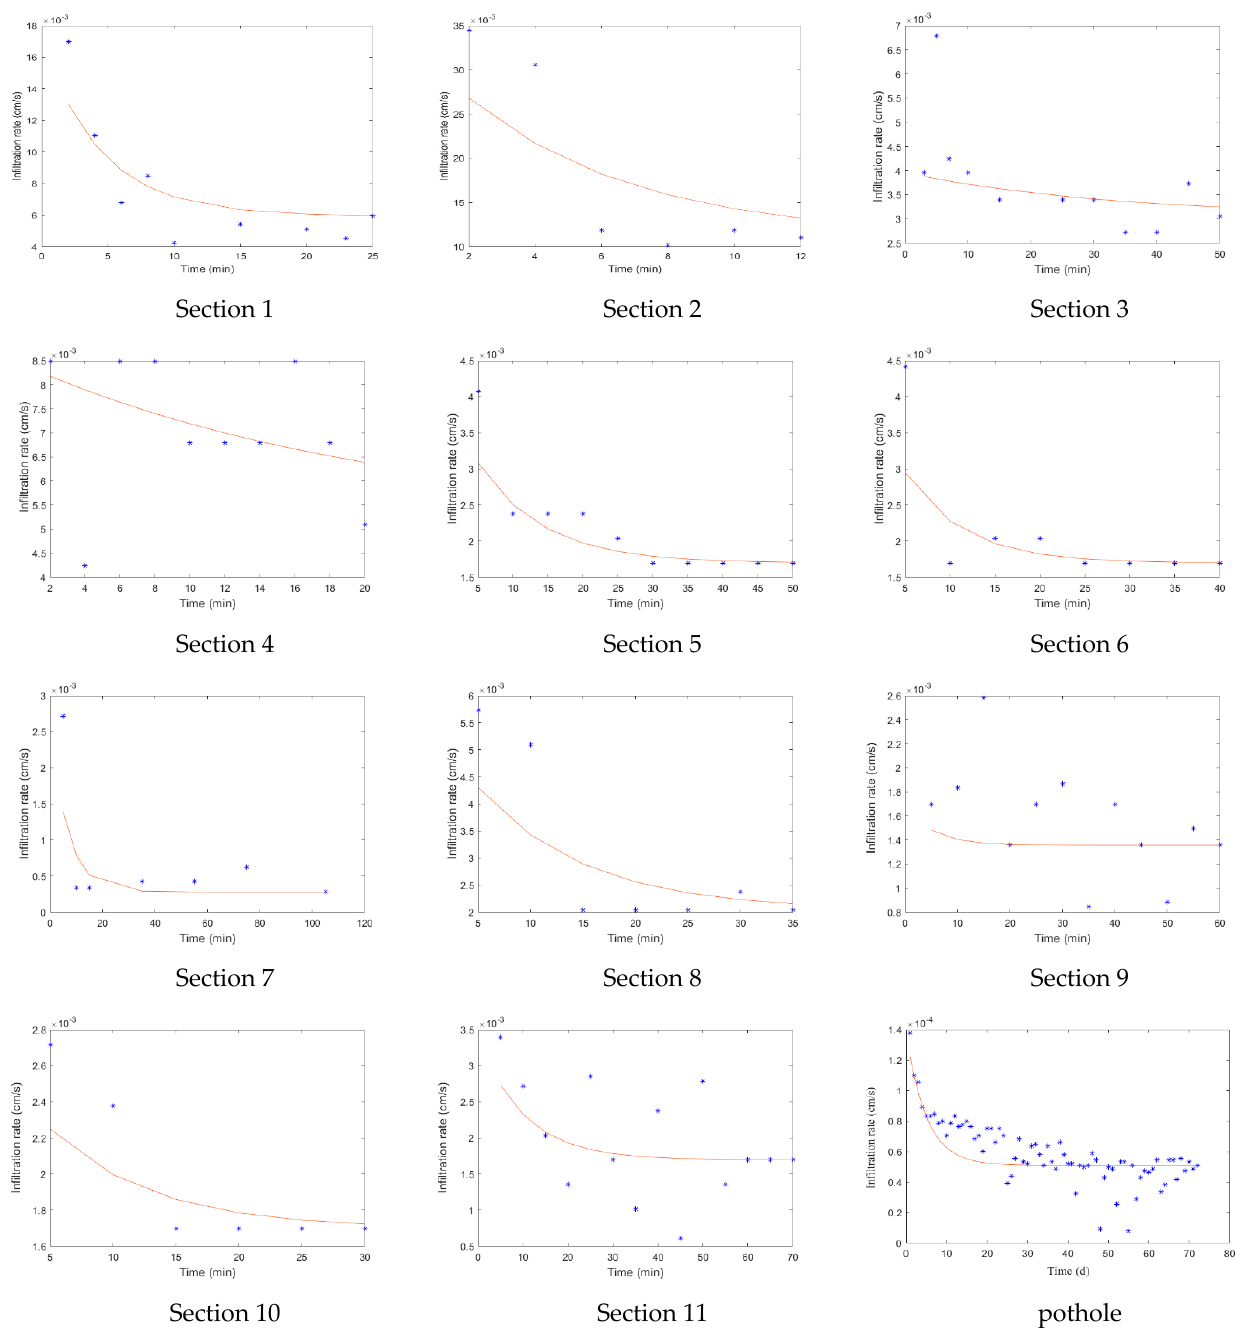
Figure 5. Fitted curve of the infiltration rate of 11 sections and pothole. The blue asterisk indicates the field measured infiltration rate, and the red line indicates the fitted riverbed infiltration process.